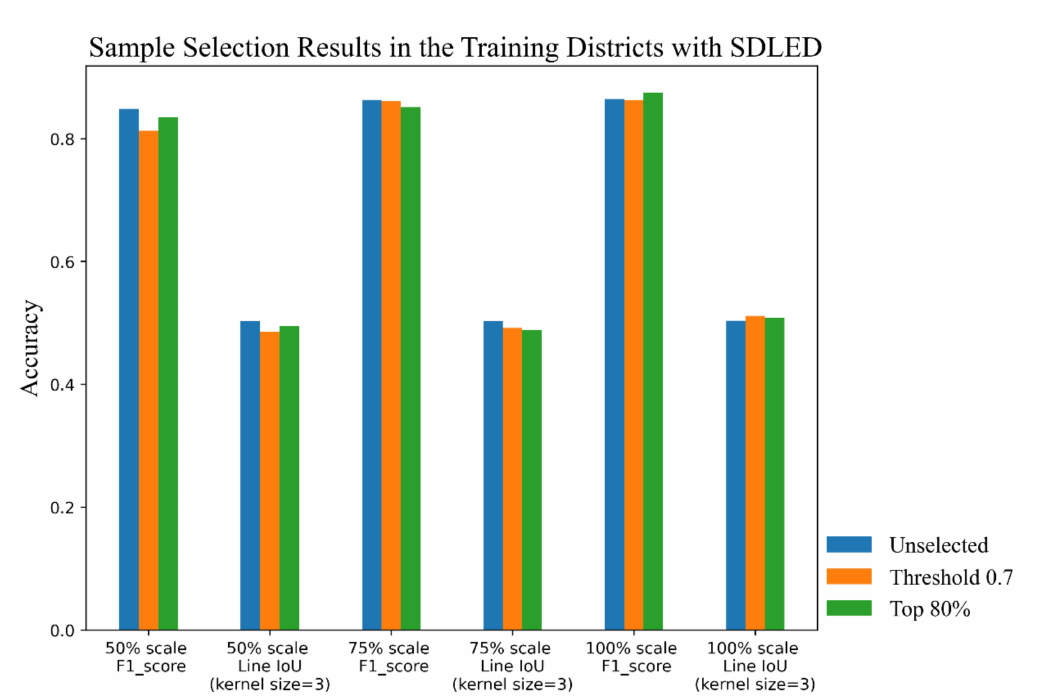
Figure 10. Precision evaluation results for sample selection mechanism analysis in SDLED. 50%, 75% and 100% are the scale of manually labeled samples. The sample selection method calculates the ratio of the complete boundary in prediction results to the real boundary to select higher-quality pseudo-labels. Unselected means all the pseudo-labels participate in training without selection. Threshold 0.7 means the method sets a threshold of 0.7 to remove incomplete samples. Top 80% means the top 80% pseudo-labels with the highest ratio will be used for